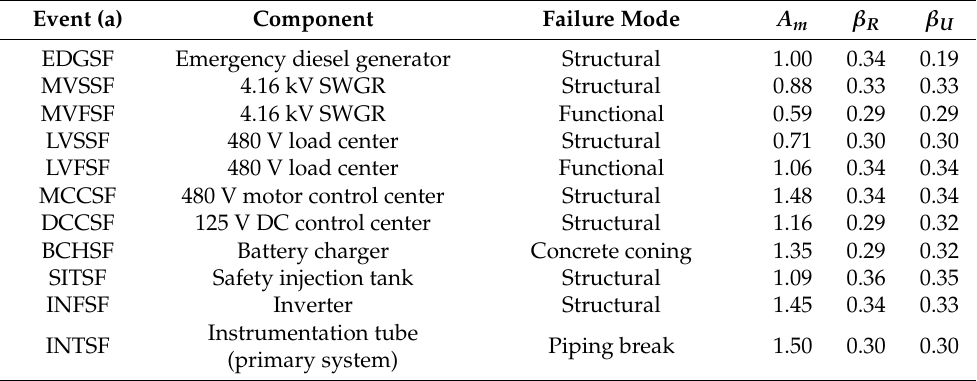
Table 6. Seismic failure